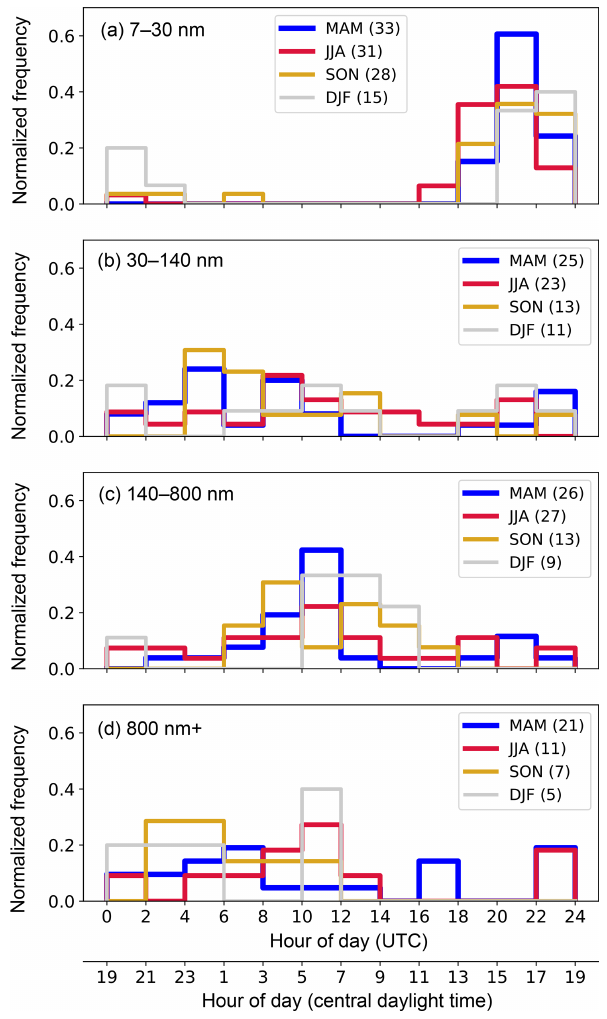
Figure 8. Normalized frequency of the daily time of peak concen- trations associated with the 24h cycle in the different modes of the aerosol number size distribution. (a) – (d) represent N 7 − 30nm , N 30 − 140nm , N 140 − 800nm , and N 800nm + , respectively. The de- scription of the figure is the same as in Fig. 6.